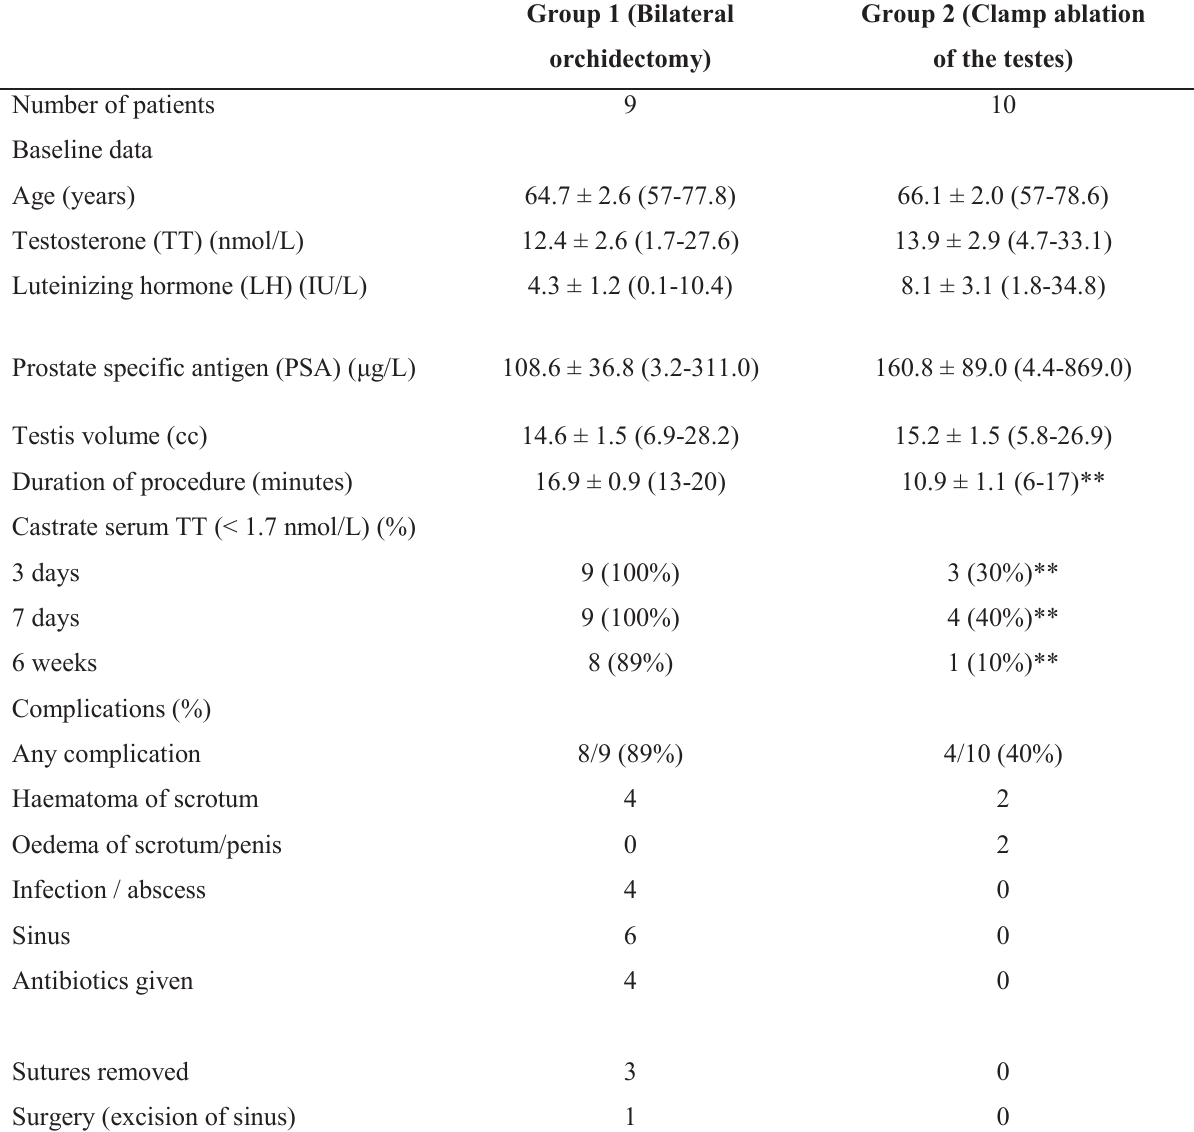
Table 1 - Study data (mean ± SE and range).